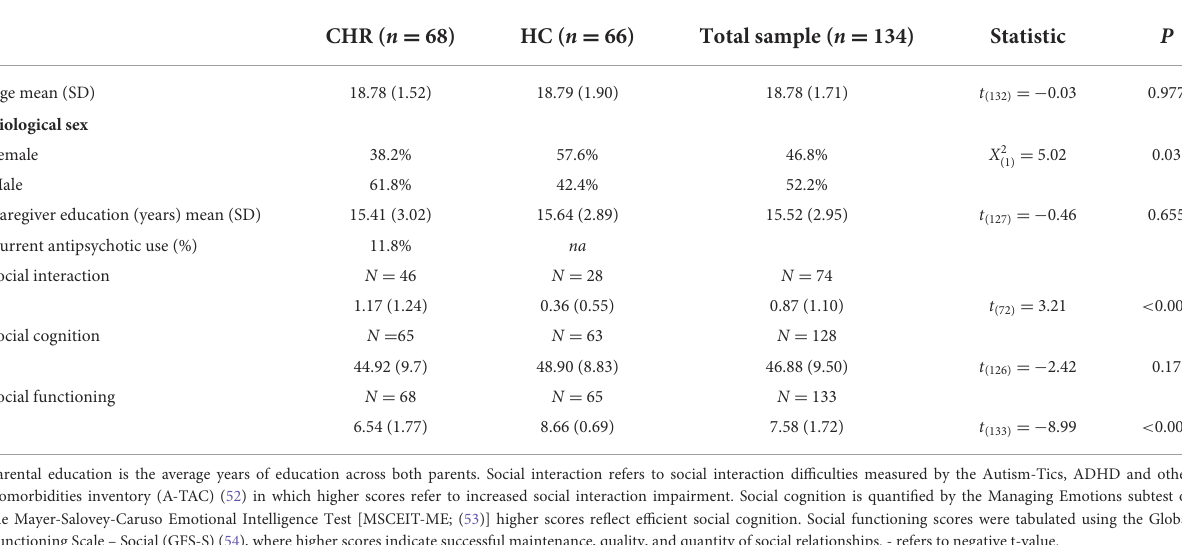
TABLE 1 Demographic and social functioning characteristics.